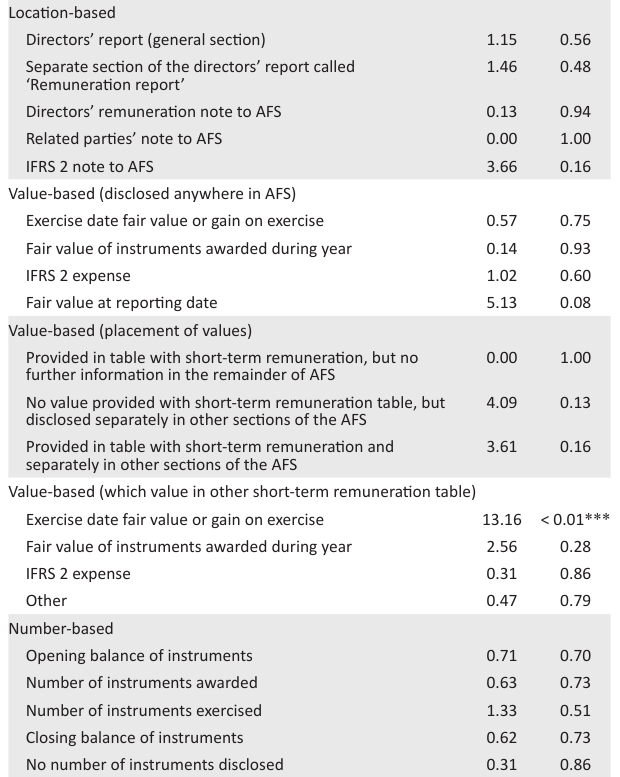
TABLE 5: Share-based remuneration compared between company sizes. TABLE 4: Share-based remuneration compared between industries .